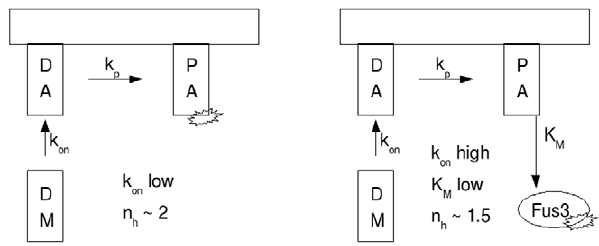
Figure 10. Schematic representation of yeast pheromone signal transduction with proper (left) and abrogated (right) Fus3-Ste5 interaction.